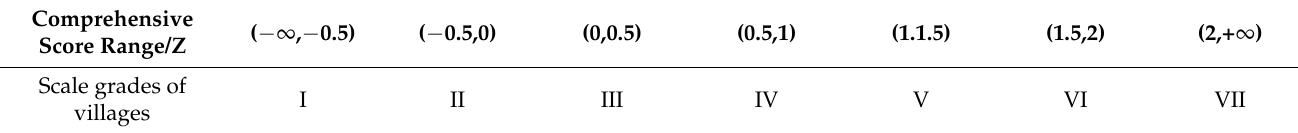
Table 2. Classification standard of villages development